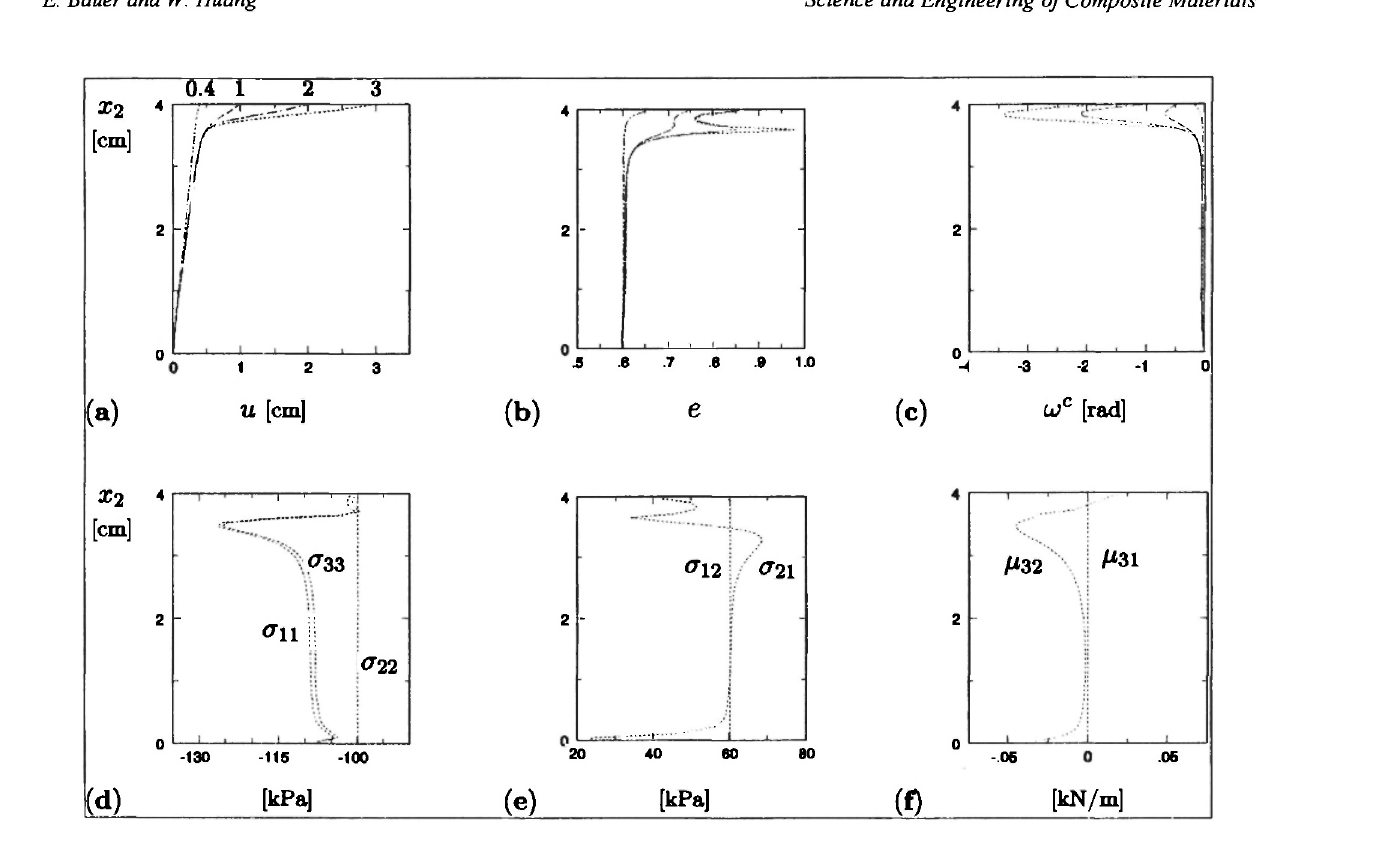
Fig. 6: Plane shearing between a very rough bottom and a medium rough top wall